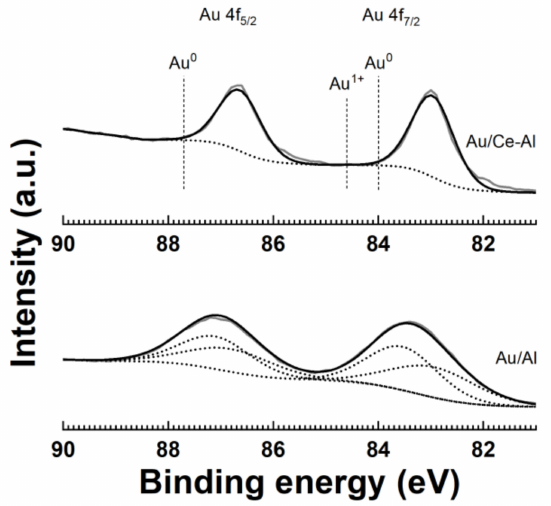
Figure 4. Au 4f spectra of the Au / Al and Au / Ce-Al catalysts (Au 0 is the theoretical binding energy value of Au 0 ).